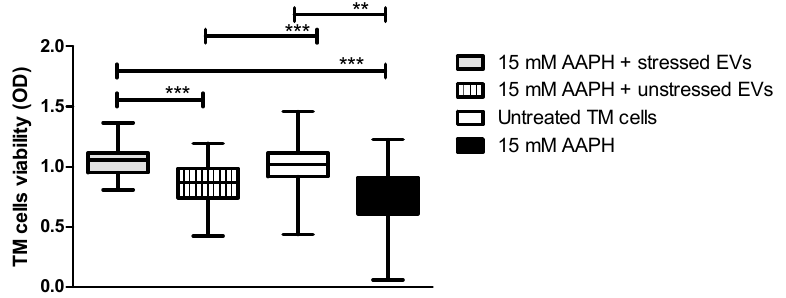
Figure 3. AAPH-treated TM cell viability after co-culture with NPCE EVs. TM cells were pretreated with AAPH (15 mM) for 1.5 h at 37 °C. Afterwards, the medium was removed and either unstressed NPCE EVs or stressed NPCE EVs were added to the TM culture, and the cells were cultured for another 24 h. E ff ect of NPCE EVs on the TM cell damage induced by AAPH was determined by MTT assay and compared to the TM cells under normal or OS conditions. Data from three independent experiments are represented by means ± SEM. Multiple group comparisons were performed using one-way ANOVA followed by the post hoc Tukey’s test, where ** p < 0.01, *** p <